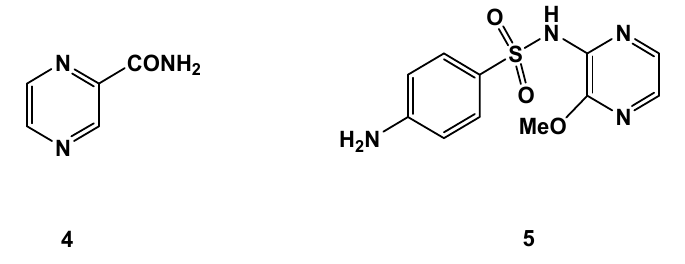
Figure 2. Antibacterial pyrazines 4 and 5 .